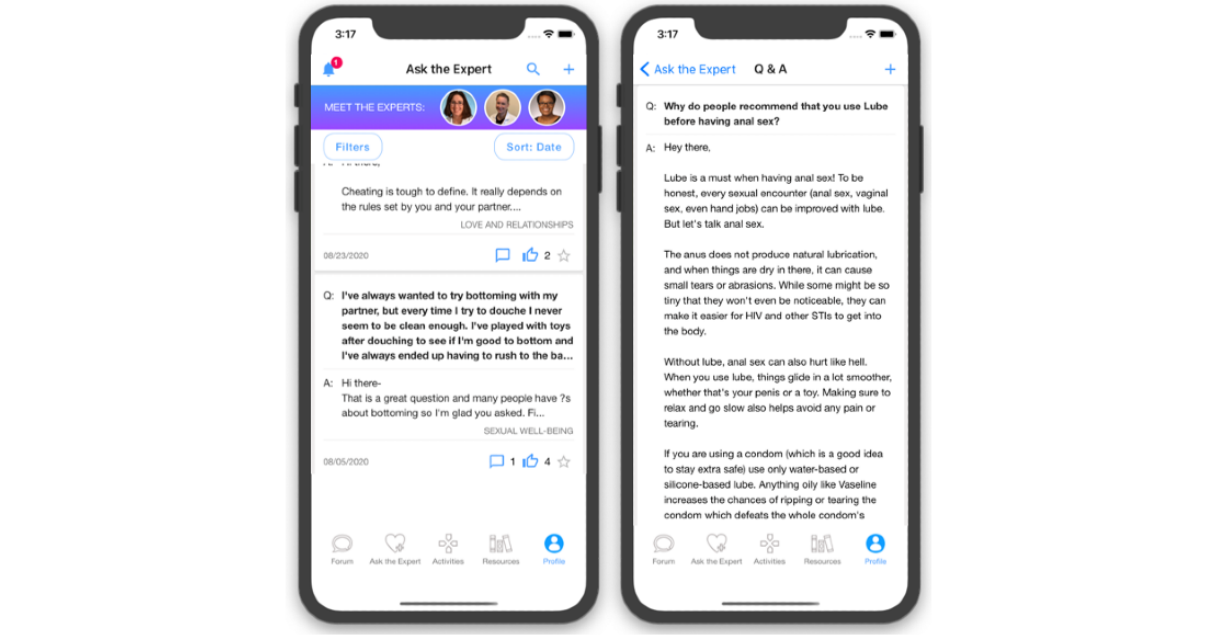
Figure 6. Example Ask the Expert screenshots from HealthMpowerment (HMP) 2.0 intervention arms